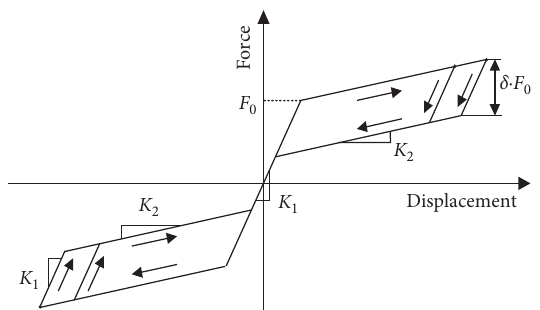
Figure 2: Constitutive model of self-centering material in Ref.